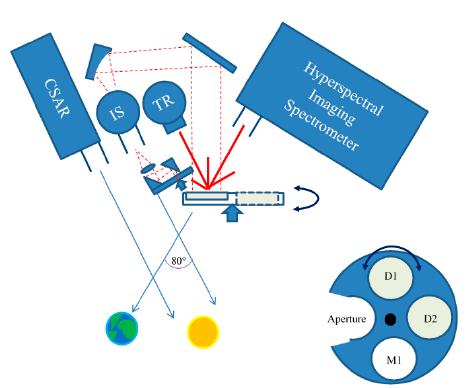
Figure 11. LD illuminates the diffuser, via the integrating sphere (IS), and this is viewed by the HIS and IS.